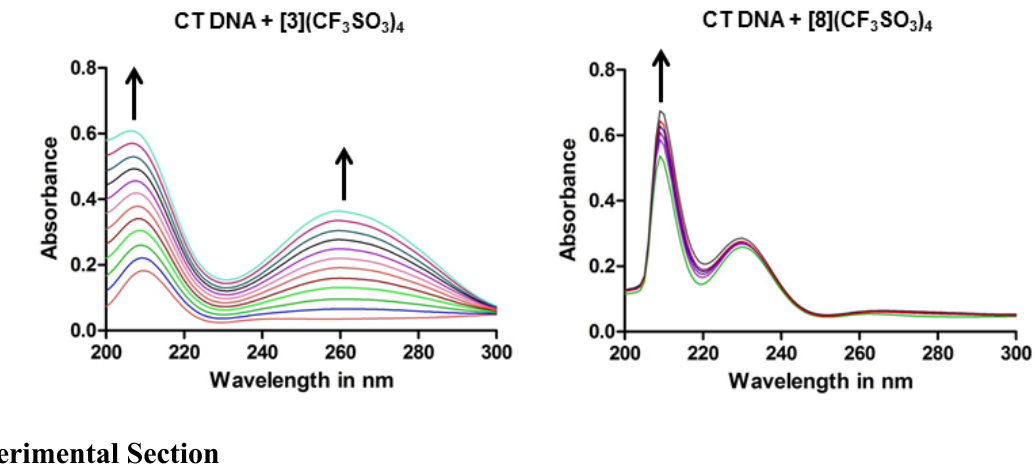
Figure 8. UV-visible spectra obtained with metalla-rectangles [ 3 ](CF SO ) upon interaction with CT [ 8 ](CF 3 3 4